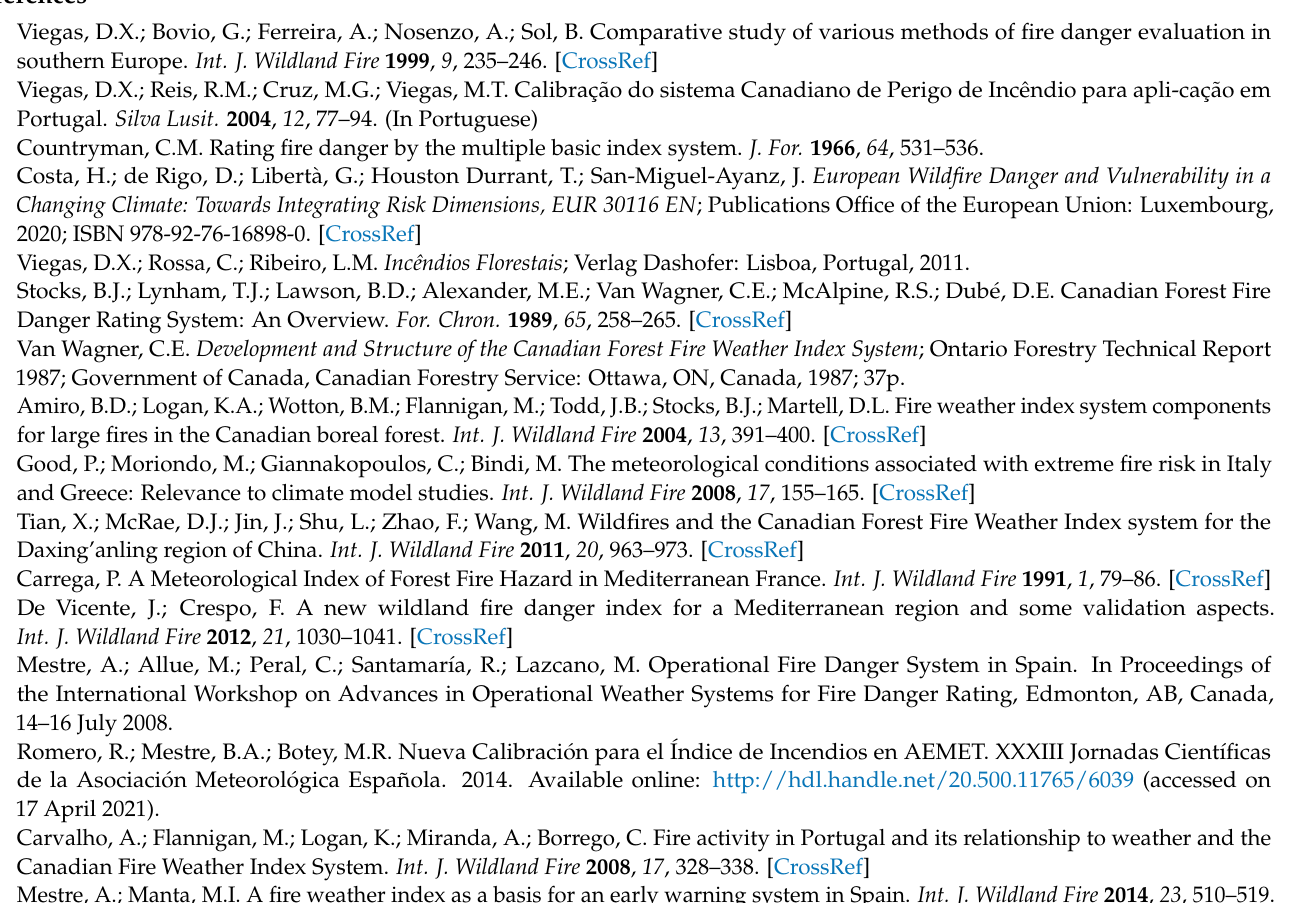
Figure A14. Final proposal of the threshold FWI values for each pair of District in Portugal (PT) and Province and Spain (SP)—Class 3 of 5 danger classes.